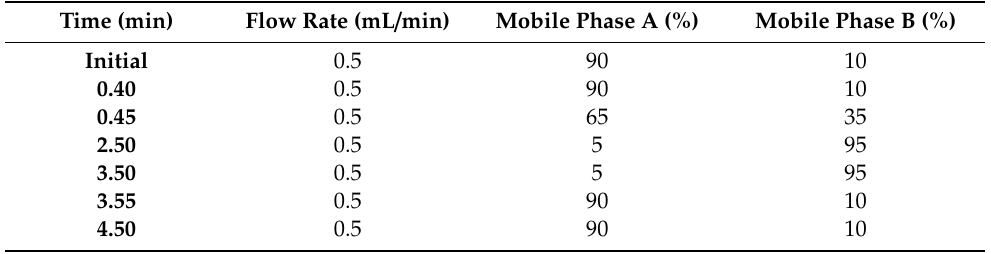
Table 6. Gradient elution profile for the chromatographic separation of GMC1 and IS from matrices.